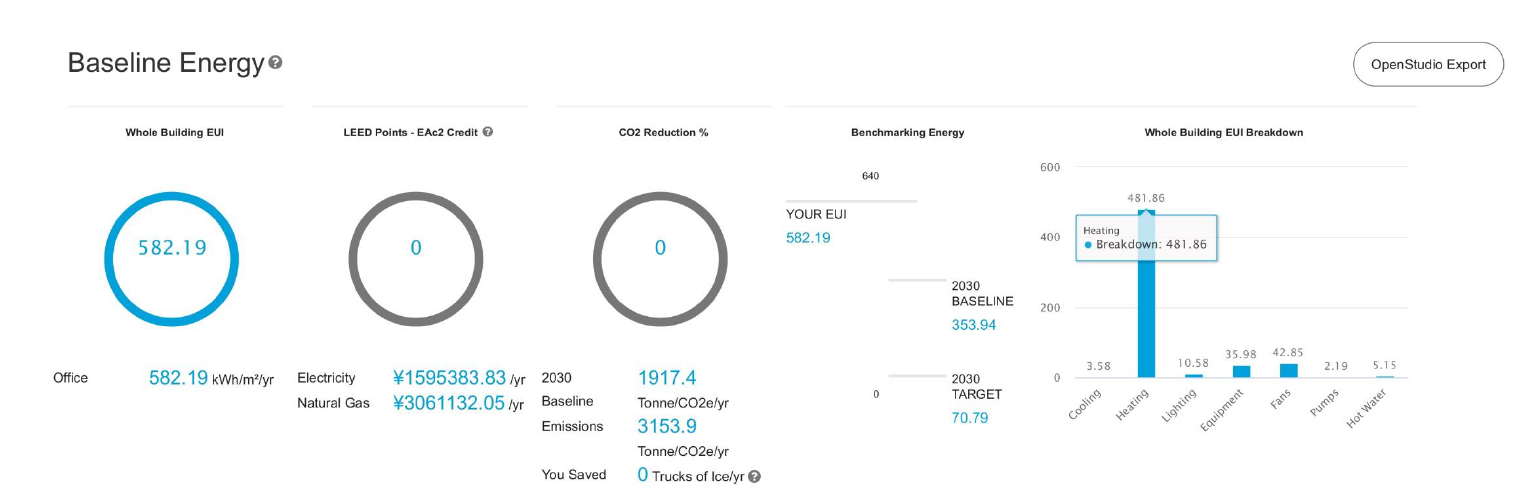
Clean Technol. 2022 , 4 , FOR PEER REVIEW Figure A23. Zone 5-A Shenyang, Liaoning (post-COVID-19 78% scenario). Figure A23. Zone 5-A Shenyang, Liaoning (post-COVID-19 78% scenario).